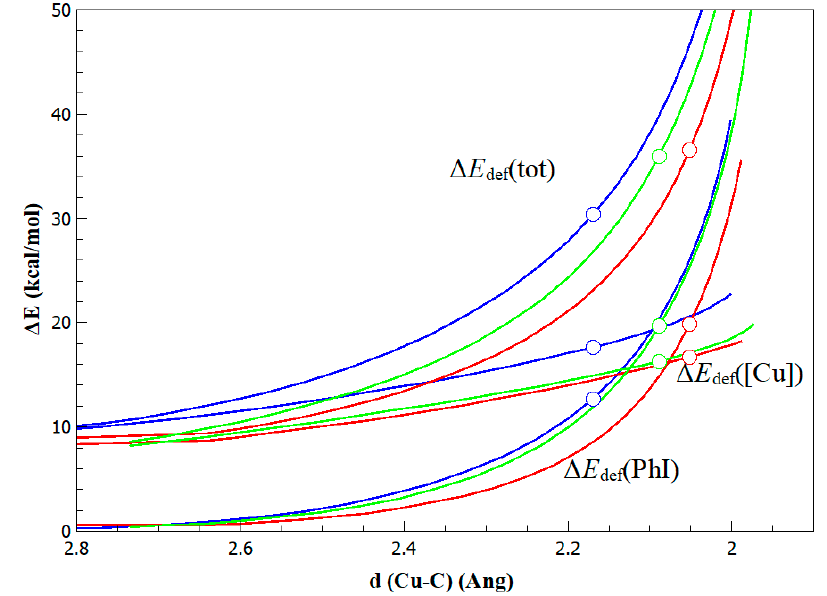
Figure 4. Contributions to the total strain energy along the reaction coordinate of the oxidative addition reaction of PhI ( 1 ) to [(phen)Cu I (XPh)] where X = NH (blue curves), X = O (red curves), and X = S (green curves). The position of the corresponding TSs is indicated by a dot. All data were computed at the B3LYP + D3(BJ)/def2-TZVPP//B3LYP/def2-SVP level of theory.